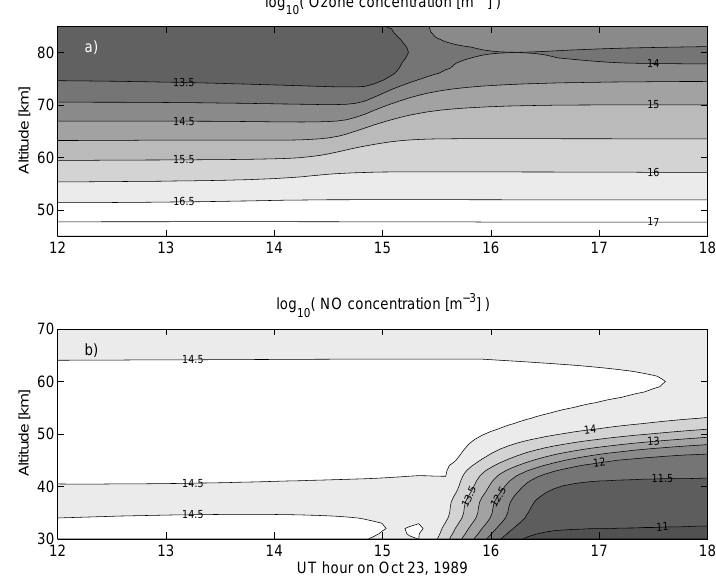
Fig. 3. Modelled variation of (a) ozone and (b) nitric oxide concentrations during the sunset of 23 October 1989. D-region, below 70 km, are of the order of 10 7 –10 8 m − 3